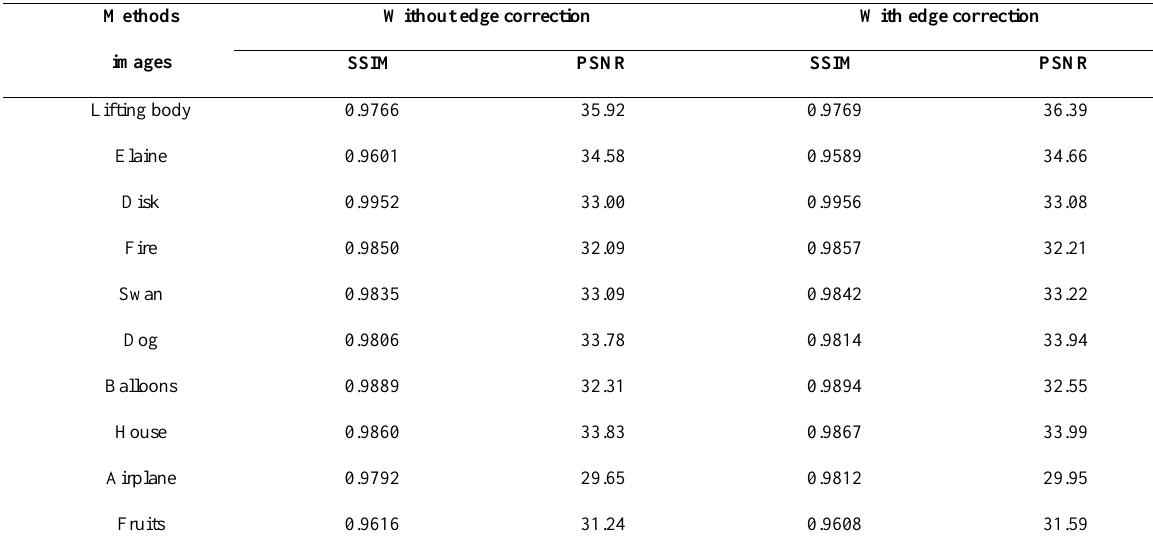
Table 4. Results of running RQRBF with suitable c on different images using SSIM and PSNR, with and without edge correction by factor of 2 in